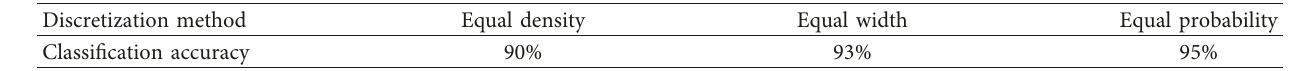
Figure 5: Performance comparison of features from time and frequency domains. Table 4: Classification accuracy of SVM based on different discretization methods.